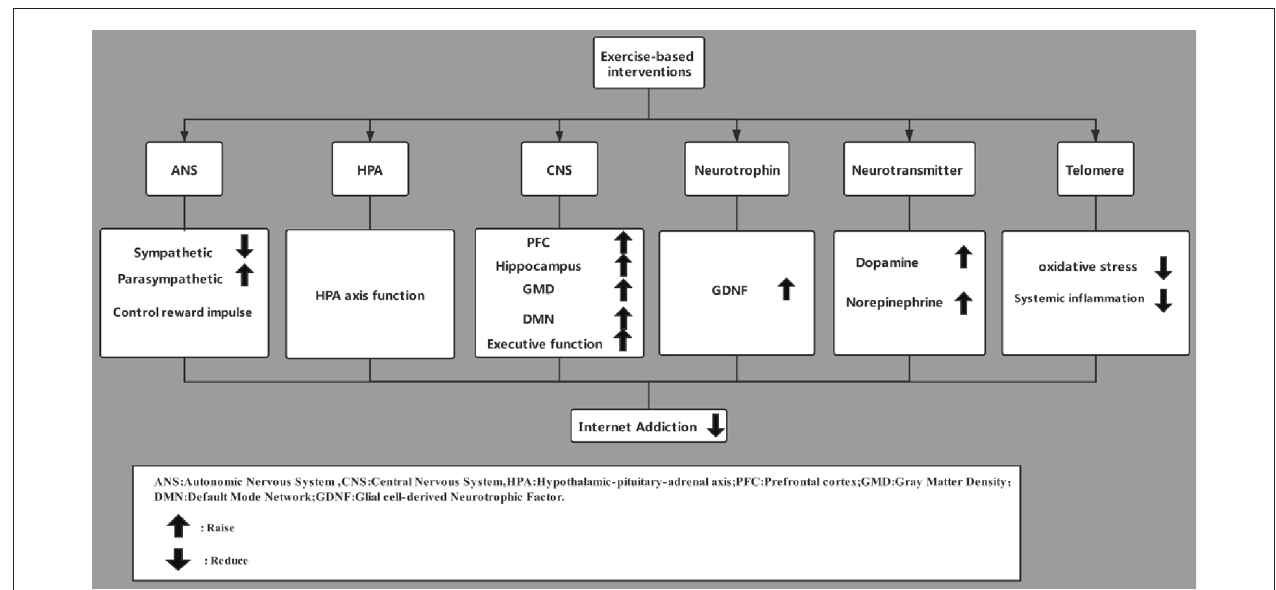
FIGURE 2 | How exercise-based interventions may influence the neurobiology of internet